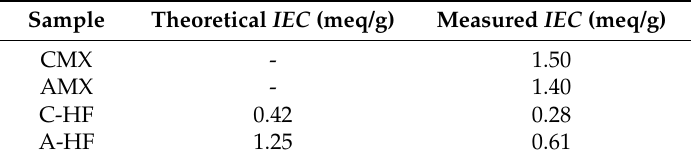
Table 3. Ion exchange capacities of the hollow fiber type IEMs and the commercial IEMs.